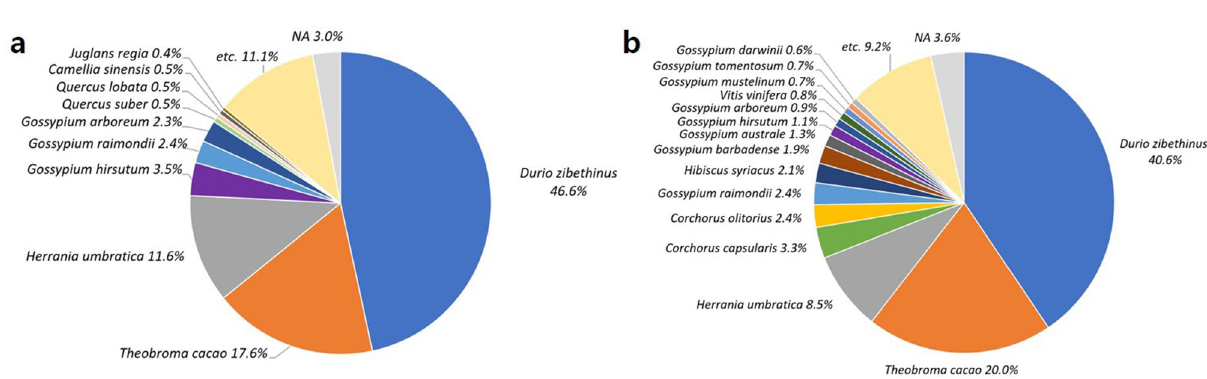
Figure 2. Species composition results from BLASTx of T. amurensis transriptome to ( a ) Refseq plant protein and ( b ) non-redundant protein